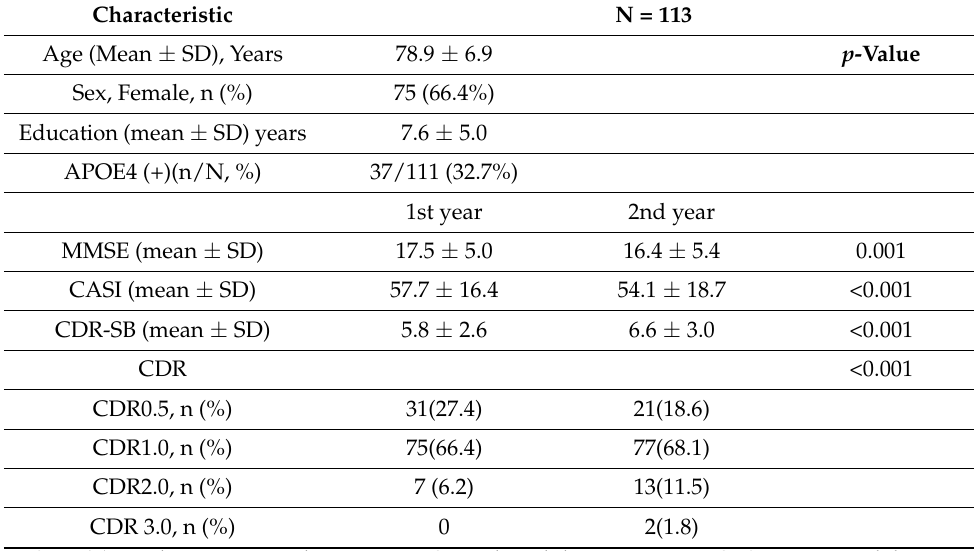
Table 1. Demographic characteristics of patients with Alzheimer’s